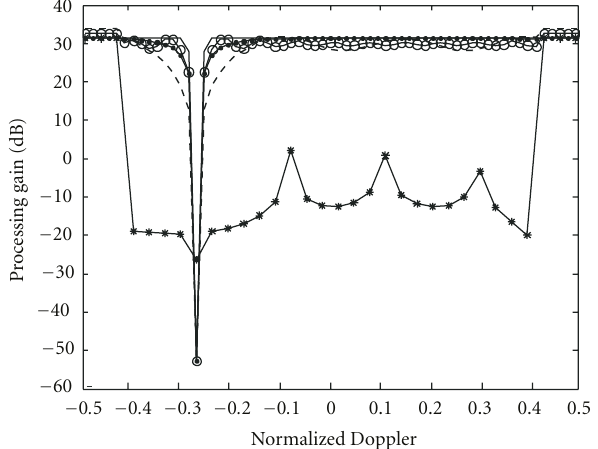
Figure 4: Performance comparison of processing options. -- Dual Tx/Rx single receiver system with 64 pulses in each Tx/Rx ( t 0 = T ; M = 4). ◦− dual Tx/Rx single receiver system with 64 pulses in each Tx/Rx ( t 0 = T , M = 12). •− Reduced STAP with 64 pulses, 128 adaptive degrees of freedom ( N B = 2). − Ideal curve (standard STAP with 1408 degrees of freedom) with 64 pulses and 22 receiver channels. ∗− FFT solution (available via single A/D).